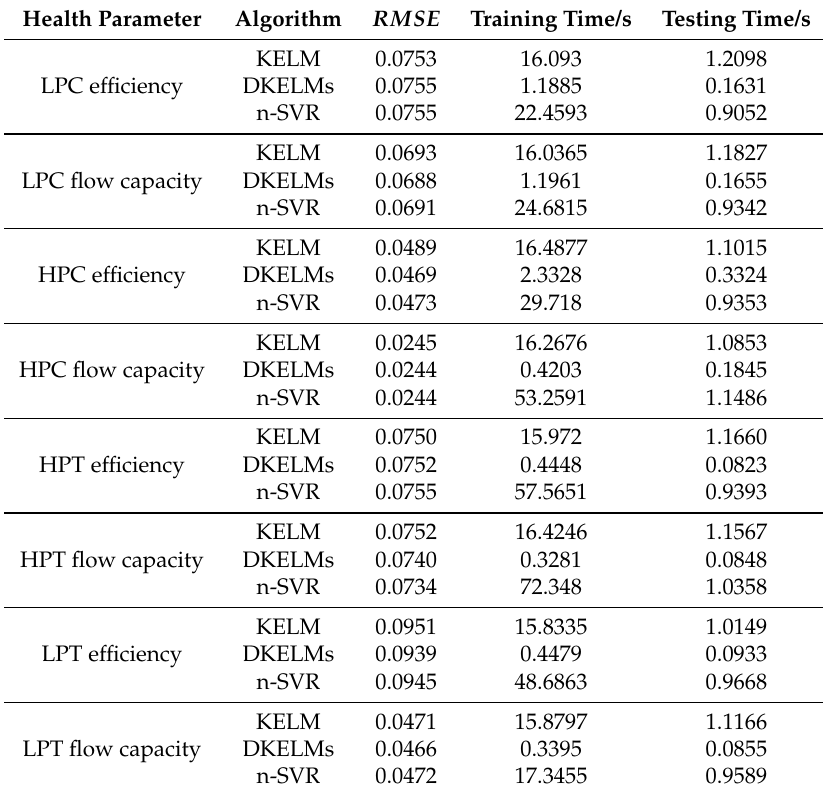
Table 7. Performance comparison for degeneration